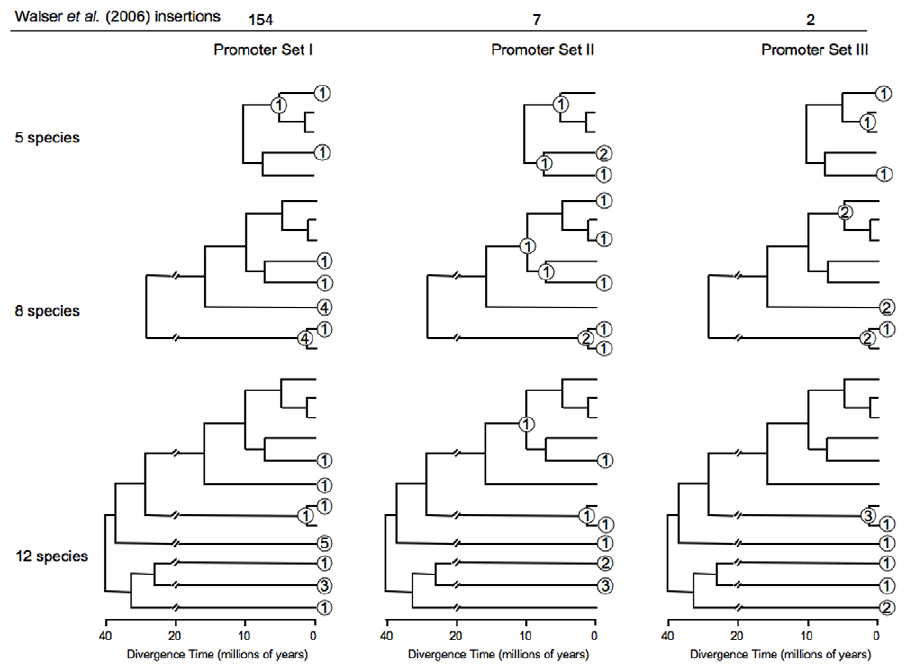
Figure 2. Phylogenetic distribution of transposable element insertions into proximal promoter regions of single-copy genesets in the 12 species of Drosophila that have undergone whole-genome sequencing. Species labels are omitted due to space considerations, but are as in Figure 1. Each numbered oval represents transposable element insertions. The position of the oval corresponds to the species, species pair, or species group in which the insertion was detected. Ovals at tips are insertions restricted to single species, while ovals at nodes are found in all species emanating from that node. Insertions are represented at each level of species sampling, and all genes screened at a given level were for the same number of species. The horizontal scale indicates the time at which the species are presumed to have diverged [59] but is otherwise not pertinent to the time of the TE insertions. Double slashes represent a compression of the time scale at the base of the tree.